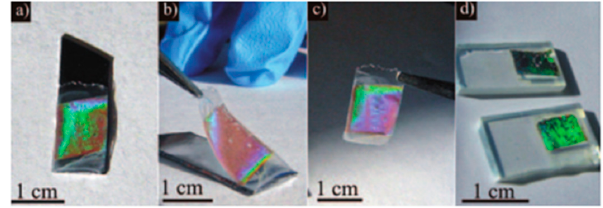
Figure 15. Transfer of a silicon inverse opal photonic crystal onto dye sensitized ZnO nanowire electrodes [108]. electrodes